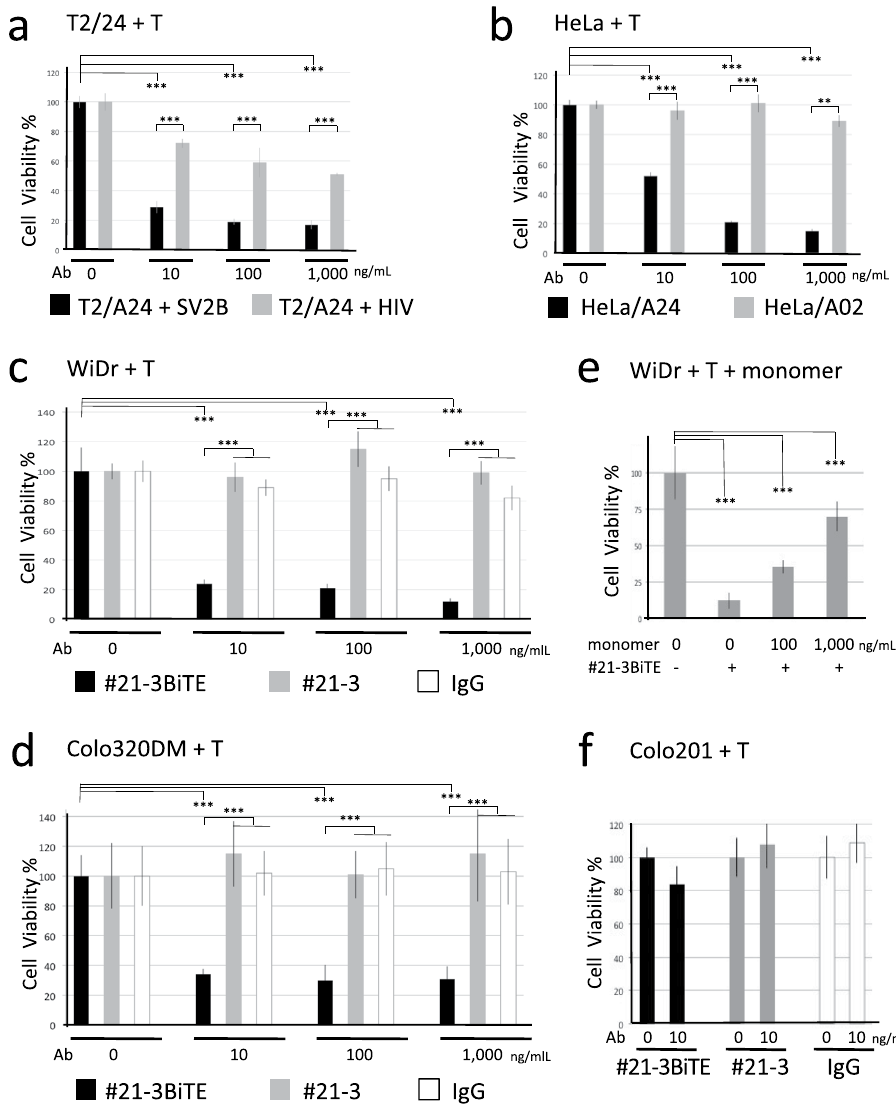
Figure 5. #21-3BiTE shows potent T-cell dependent cytotoxicity against surviving-2B + HLA-A * 24 + tumor cells in vitro . ( a ) T2/A24 cells stably expressing luciferase were pulsed with the indicated peptide and then mixed with T-cells expanded from a HLA-A * 24 + healthy donor at an E:T ratio of 10:1 in the presence of serial dilutions of #21-3BiTE. The reactions were allowed to proceed for 8 h. Target cell viability was determined by luciferase assay. Data are representative of two independent experiments. ( b ) HeLa/A24 or HeLa/A02 cells stably expressing luciferase were mixed with T-cells at E:T ratio of 10:1 in the presence of serial dilution of #21-3BiTE, and the reactions were allowed to proceed for 12 h. Relative cell viability values for HeLA cells is determined by luciferase assay. Data are representative of three independent experiments. ( c ) WiDr cells stably expressing luciferase were mixed with the T-cells at an E:T ratio of 10:1 in the presence of serial dilution of the indicated antibody, and the reactions were allowed to proceed for 14 h. Relative cell viability values for WiDr cells was determined by luciferase assay. Representative data from three independent experiments are shown. ( d ) Colo320DM cells were treated as in ( c ), and relative cell viability values was determined by luciferase assay. ( e ) WiDr cells mixed with the T-cells at an E:T ratio of 10:1 were incubated with 10 ng/mL of #21-3BiTE in the presence of serial dilutions of SV2B 80-88 /HLA-A * 24 monomer, and the reactions were allowed to proceed for 14 h. Relative cell viability values for WiDr cells was determined by luciferase assay. Data are representative of two independent experiments. ( f ) Colo201 cells were treated as in ( c ), and the reactions were allowed to proceed for 14 h. Target cell viability was determined by luciferase assay. Relative cell viability values for target cells are represented as the average ± SD for three replicates/group ( *** p < Cell culture and stable cancer cell lines.